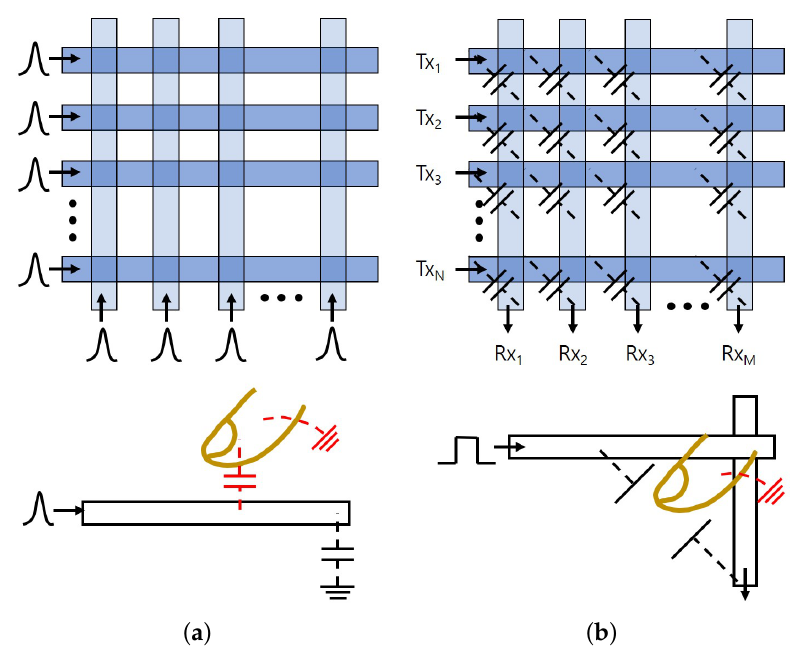
Figure 4. Projected-capacitive methods. ( a ) Self-capacitance. ( b ) Mutual